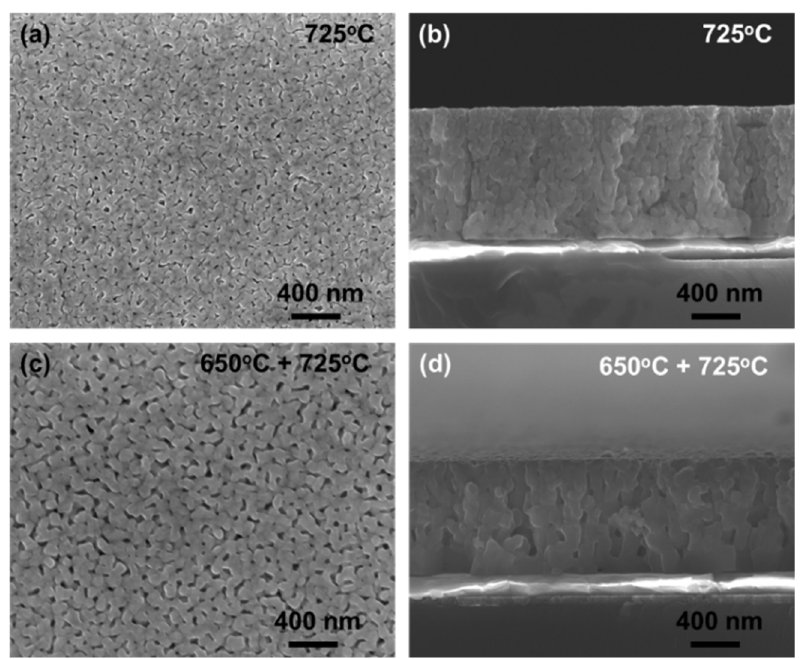
Figure 3. Surface and cross–sectional SEM images of the BNT–5.5BZ thin films annealed under different conditions: ( a , b ) 725 °C, and ( c , d ) 650 °C + 725 °C films.